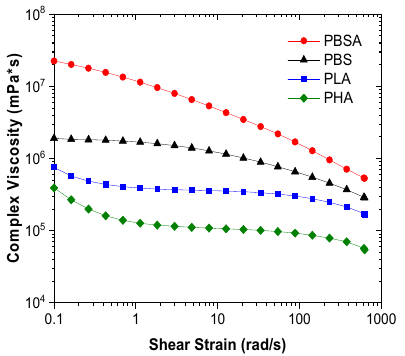
Figure 3. Bioplastic complex viscosity measured at lamination temperature.